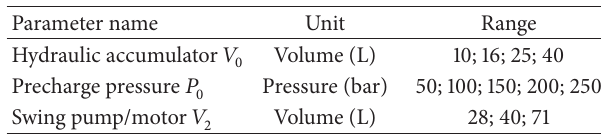
Table 1: Parameter names and their